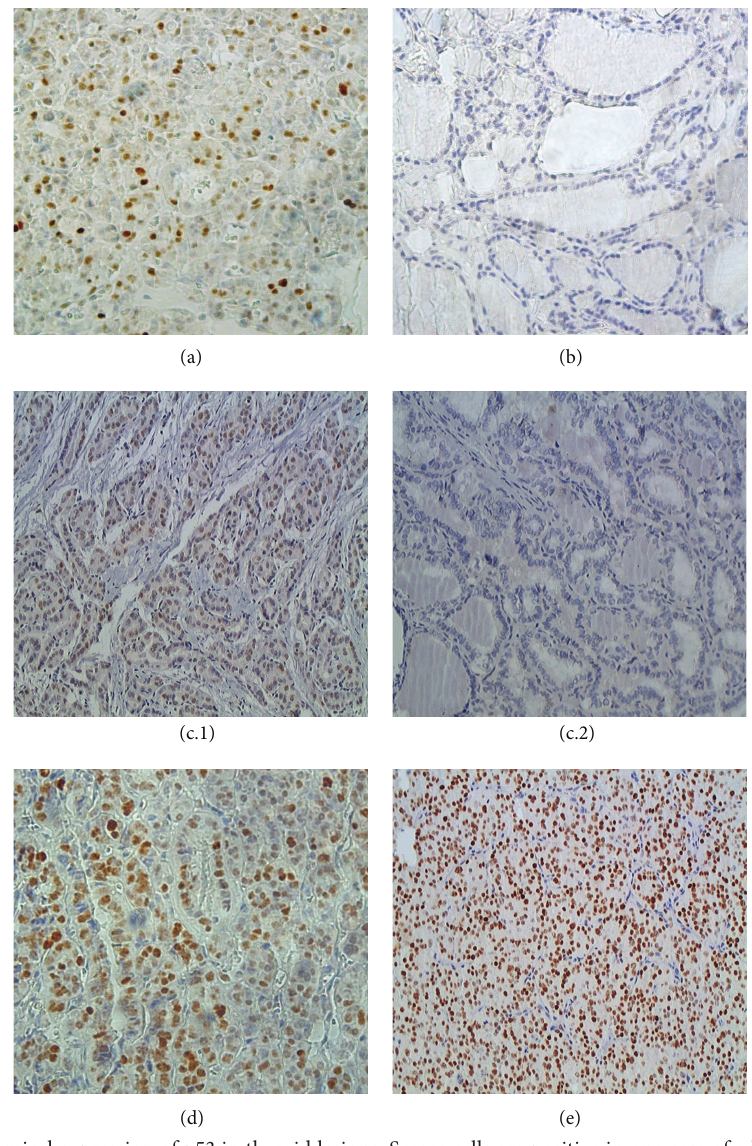
Figure 1: Immunohistochemical expression of p53 in thyroid lesions. Scarce cells are positive in one case of adenoma ( × 500); (b) negative goiter nuclei ( × 400); (c.1) papillary carcinoma showing high expression of p53 ( × 400); (c.2) papillary carcinoma showing negative expression; (d) follicular variant of papillary thyroid cancer showing moderate expression of the protein ( × 640); and (e) follicular carcinoma showing high expression of p53 ( ×